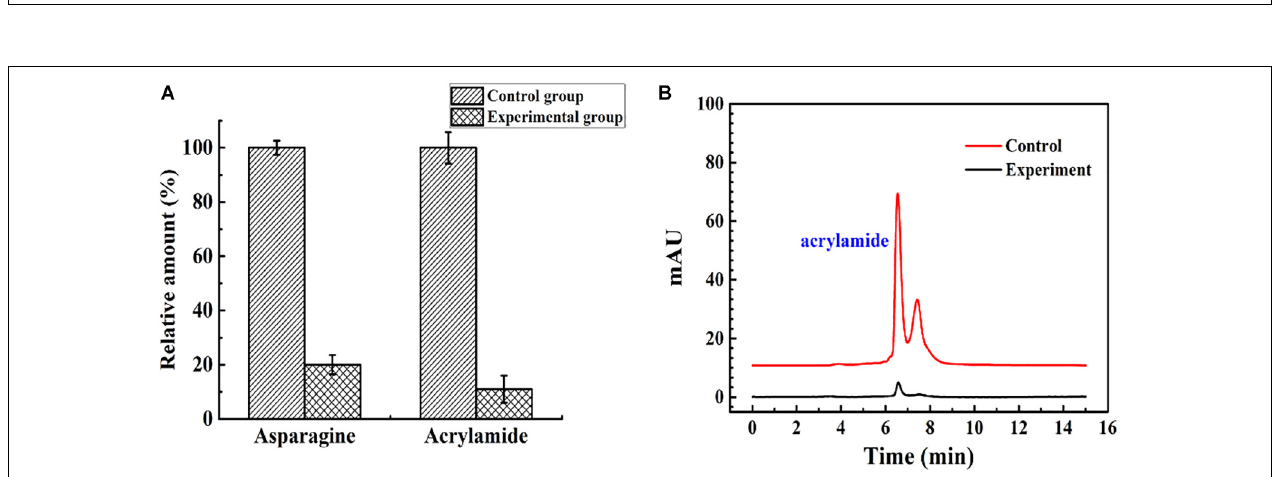
FIGURE 9 | The control group and experimental group were the simulated food components that did not flow into, and flow out of, the enzyme reactor, respectively. (A) The relative amount of asparagine and acrylamide of the control group and experimental group. (B) The result of acrylamide formation in simulated system detected by